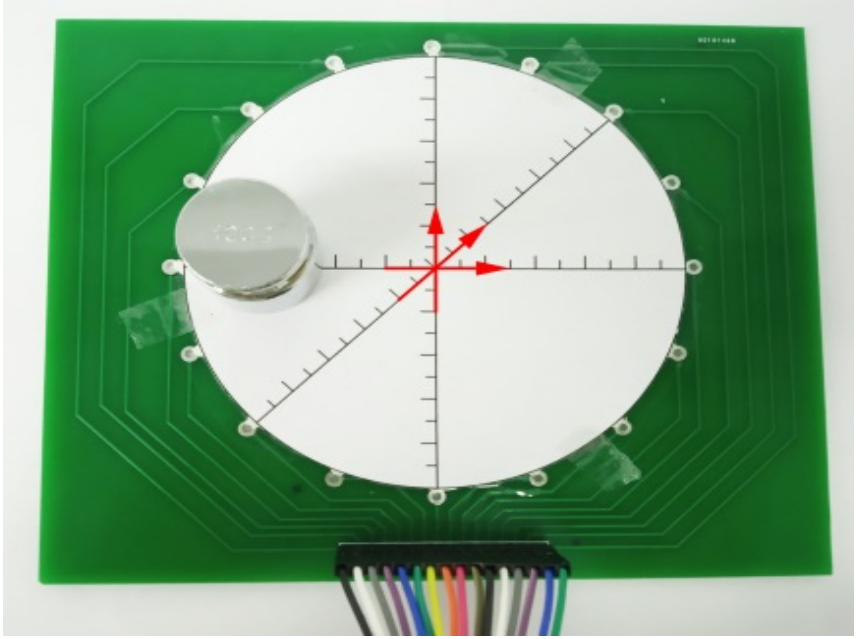
Figure 9. The device of positional detection in OpenCV.